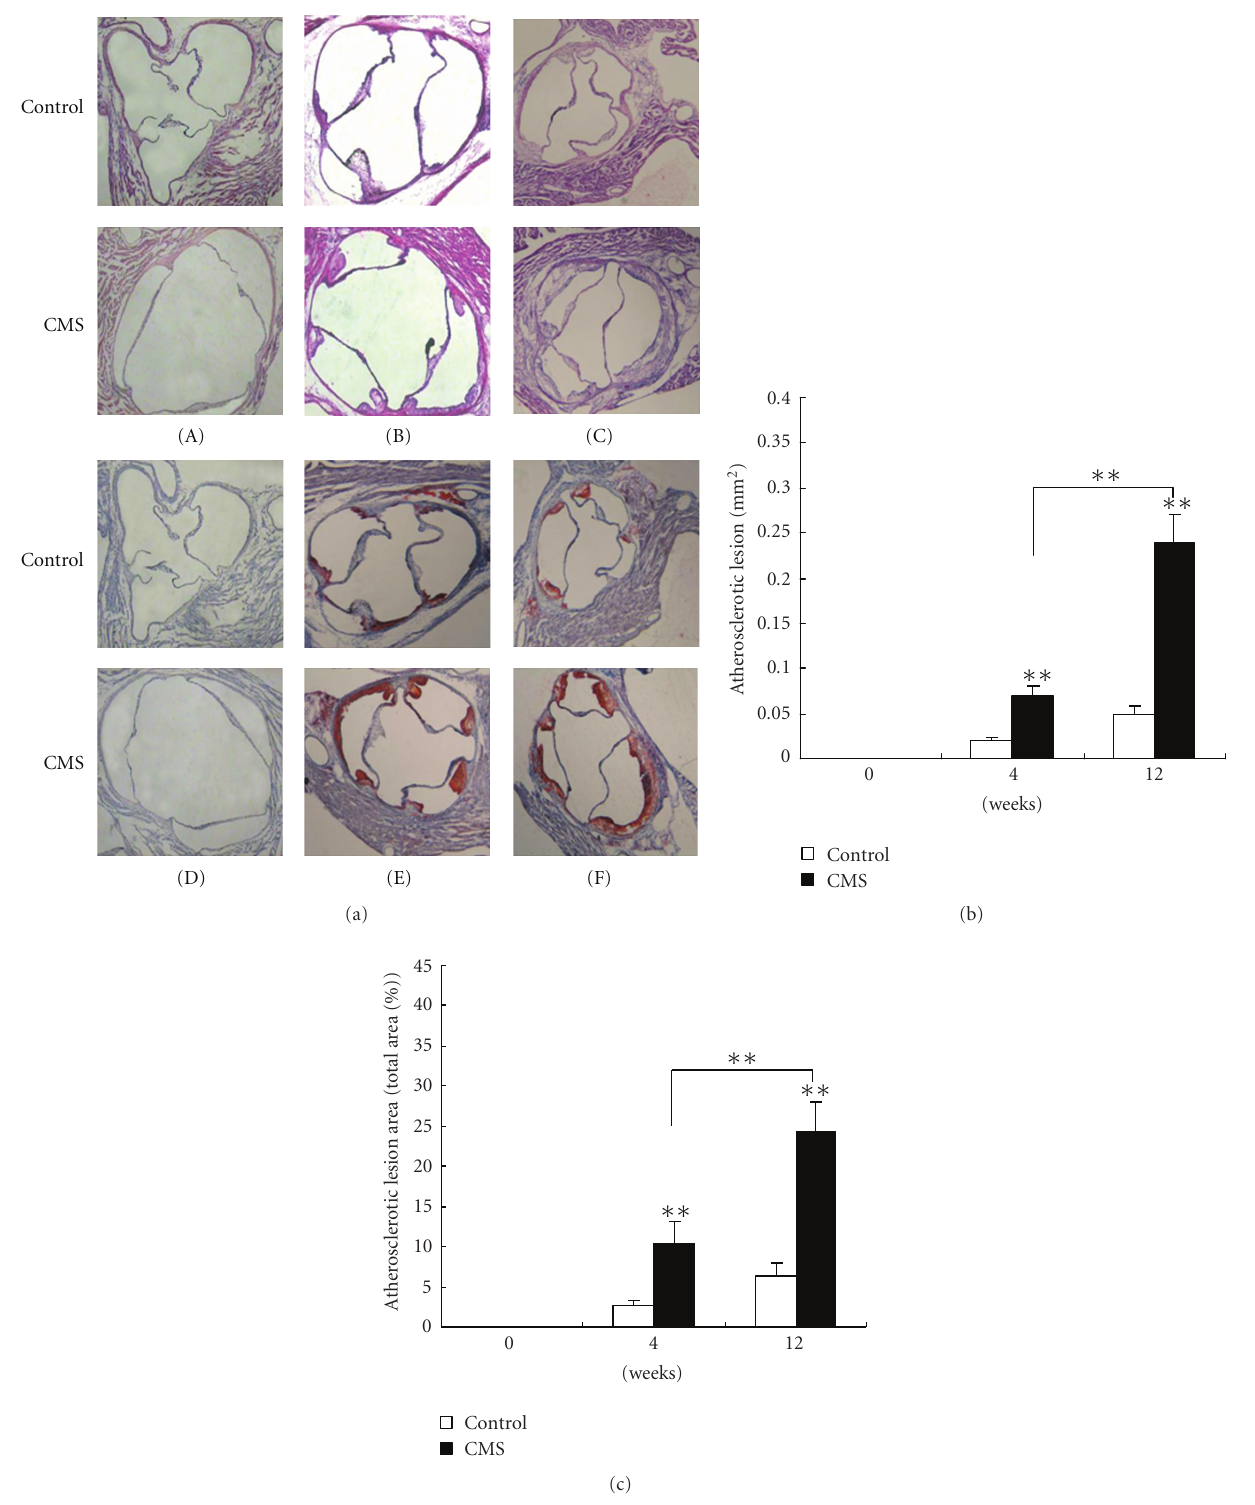
Figure 5: CMS markedly increases the extent of atherosclerosis development in aortic sinus of apoE-/- mice. (A)–(F) Representative photographs of aortic sinuses from control apoE-/- (top) and CMS (bottom) apoE-/- mice. 6 μ m frozen sections of apoE-/- mice subjected to CMS or normal condition (control) for 0 week (A), (D), 4 weeks (B), (E), 12 weeks (C), (F) were stained with H&E (A)–(C) and oil red O (D)–(F), respectively. (b), (c) Quantification of plaque areas in aortic sinuses in CMS and control apoE-/- mice stained for lipid deposition with oil red O. Each bar represents mean ± SEM ( n = 10 per group). Total plaque area in CMS mice was significantly increased compared with corresponding control mice. ∗∗ P < . 01, ∗∗∗ P < . 001 versus the control group. (Magnification ×